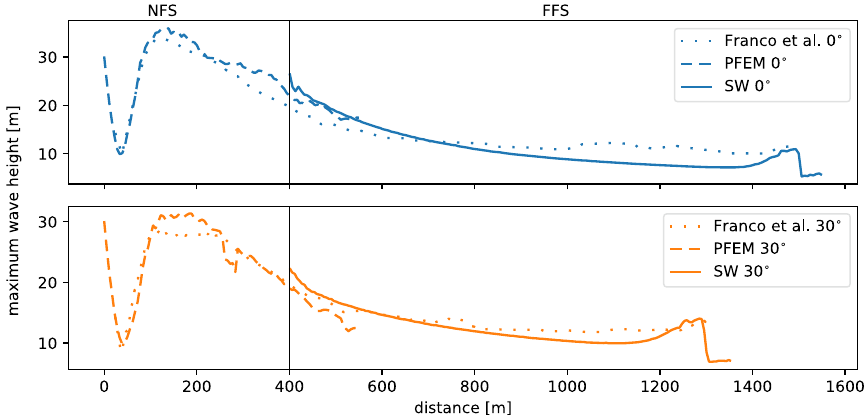
Fig. 14 Landslide in a representative lake. Envelope of the free-water-surface elevation along sections S1 and